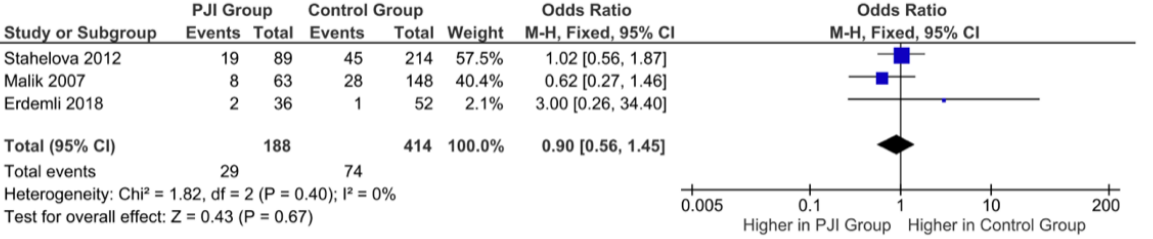
Figure 3. Forest plot indicating no statistically significant association between C/C genotype poly- morphisms of the IL6-174 gene and the incidence of PJI following TJA.